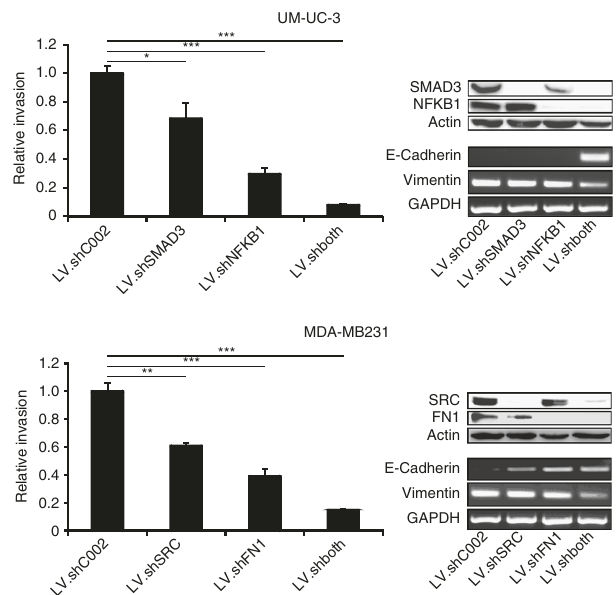
Fig. 6 Validation of in silico knockout simulations by gene knockdown experiments. By in silico simulations, we identi fi ed the most effective combination of double knockouts regarding reversal of EMT. The invasive potential of UM-UC-3 and MDA-MB231 was measured by Boyden chamber assay upon treatment with lentiviral vector expressing SMAD3 , NFKB1 , SRC , or FN1 -speci fi c shRNA, alone or in combination ( left panels ). Changes of EMT markers E-Cadherin and Vimentin after gene knockdown are shown on transcriptional level ( right panels ). Fold-changes were calculated relative to control cells (treated with control LV.shC002; set as 1). All error bars indicate s.e.m. For statistical signi fi cance t -test was used (* P -value < 0.05; ** P -value < 0.01; *** P -value < 0.001). ShRNA ef fi ciency was con fi rmed